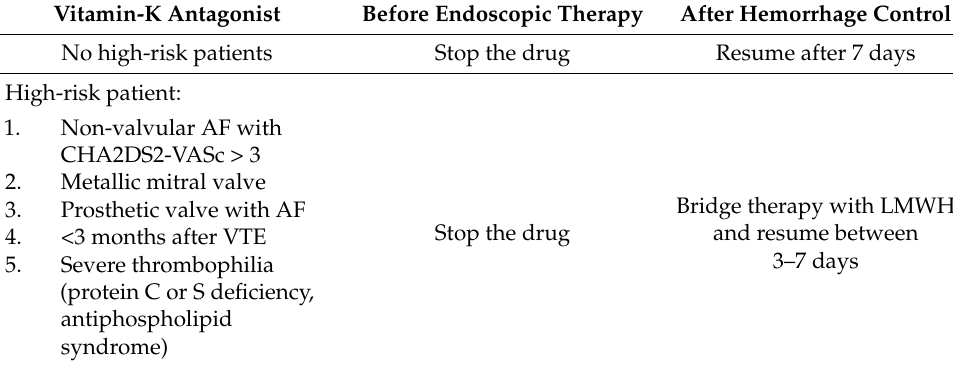
Table 4. Vitamin-K antagonist anticoagulants management in non-variceal upper GIB.